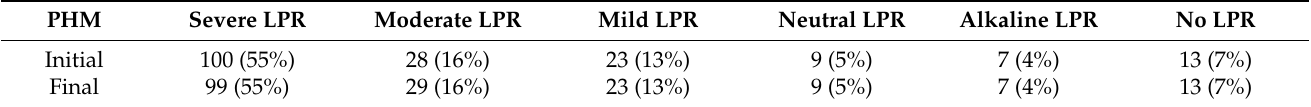
Table 2. Results of oropharyngeal pH-monitoring before and after application of Horvath Score ( n = 180).